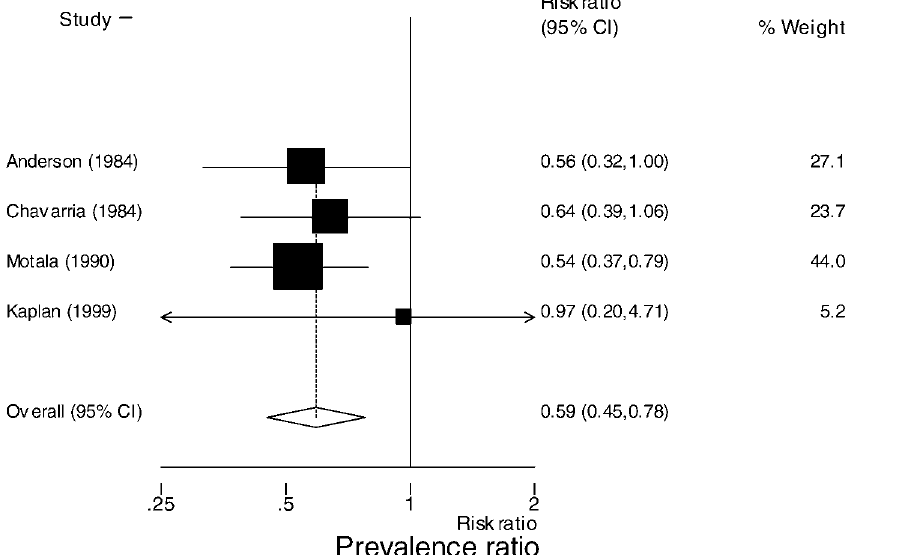
Figure 3. Meta-Analysis of Prevalence of Diarrhea at 48 h among Those on Loperamide Compared with Controls